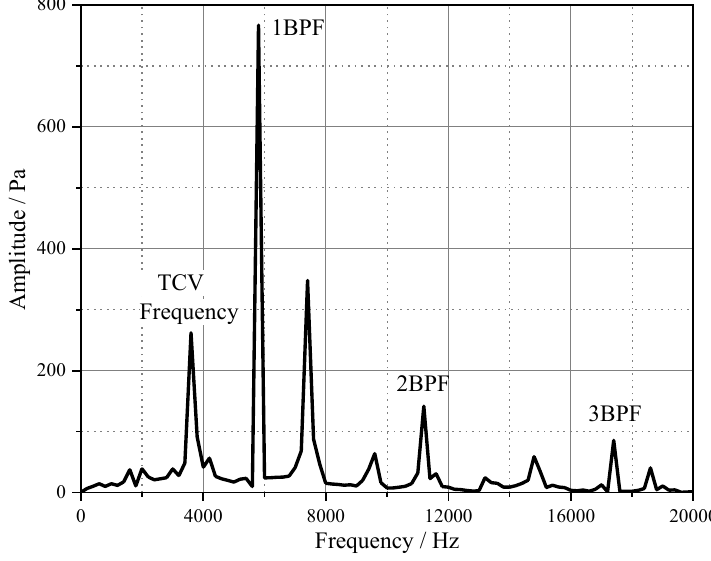
Figure 22. Pressure spectrum in front of LE under large clearance model.